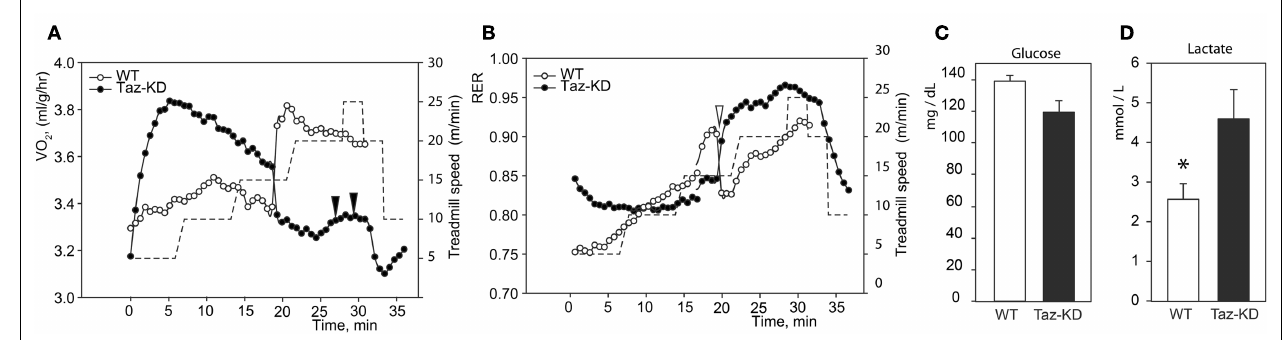
drops of RER values were present in all testedWT mice [white arrowhead on (B) ] and were totally absent or substantially blunted in Taz-KD mice.Treadmill speed is shown with dashed line [right hand axis of (A,B) ]. Blood glucose (C) and lactate (D) levels were measured inWT andTaz-KD mice immediately after completion of exercise testing ( n = 4 ). *P < 0.05